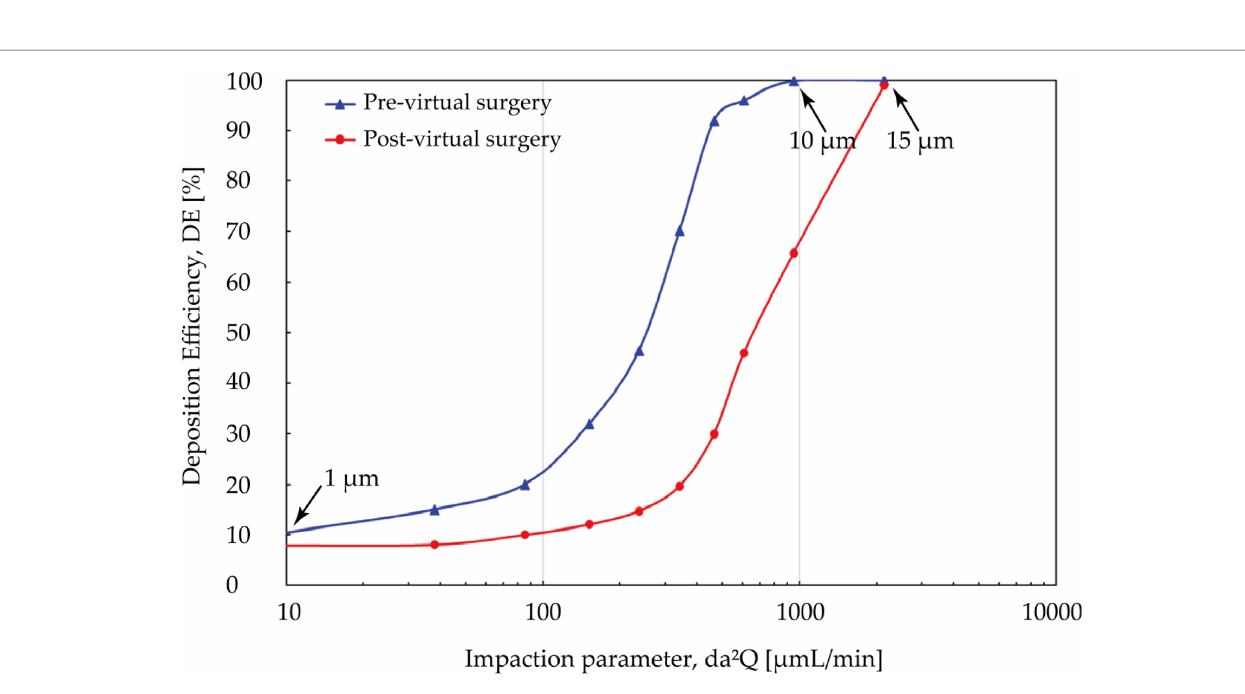
FIGURE 12 Comparison of total deposition ef fi ciency [%] for pre- and post-surgery case vs. impaction parameter under inhalation fl ow rate of 9.5 L/min. The particle diameter is with a range from 1 μ m to 30 μ